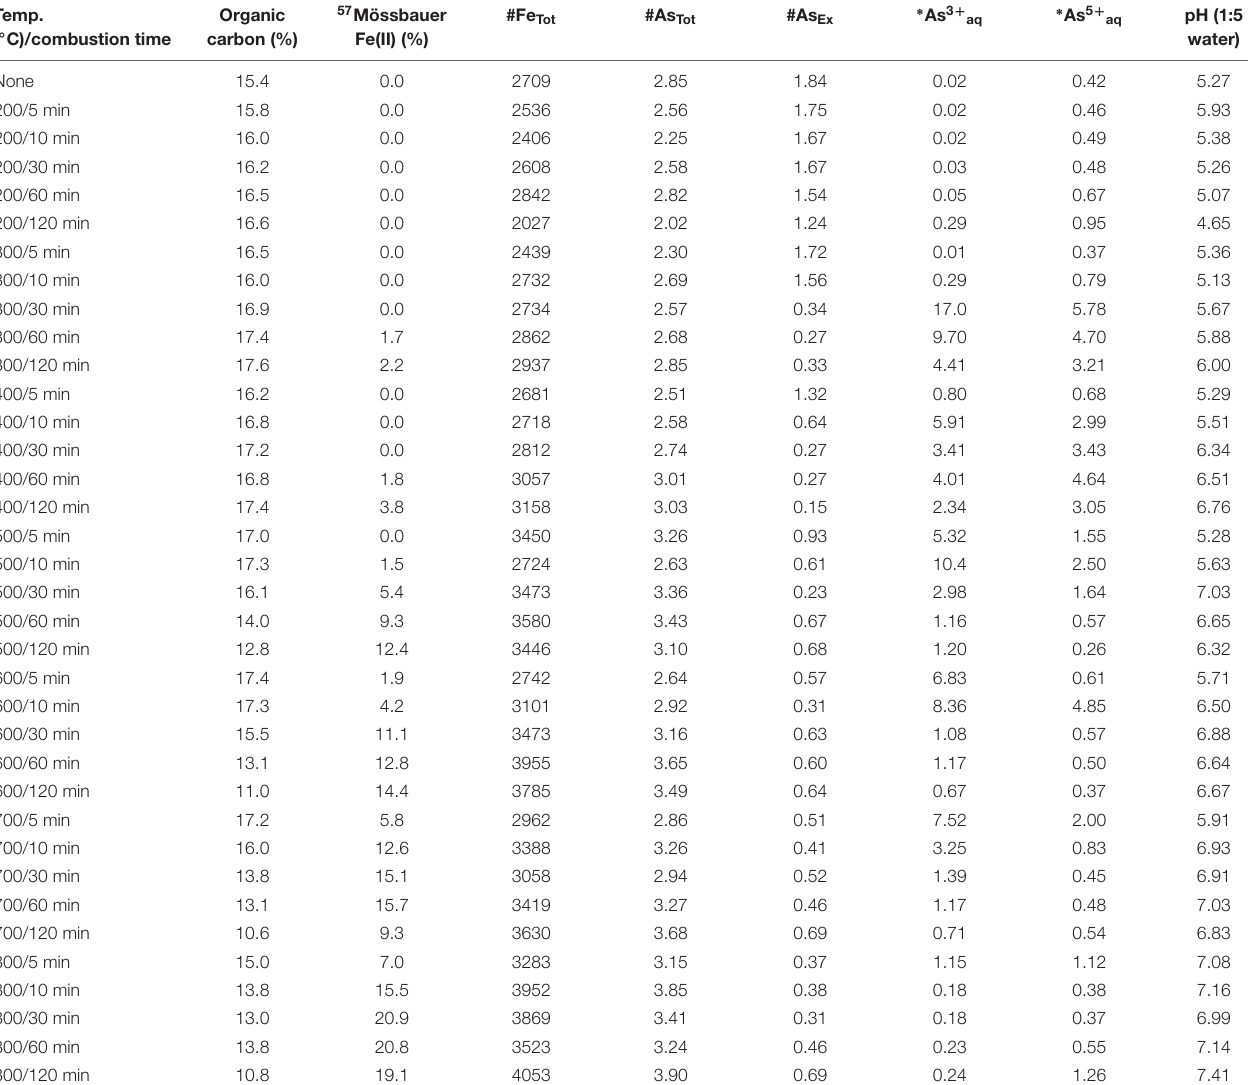
TABLE 2 | Characteristics of soil:goethite